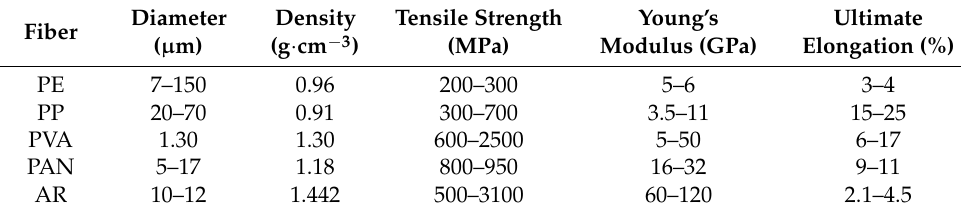
Table 1. Properties of polymer